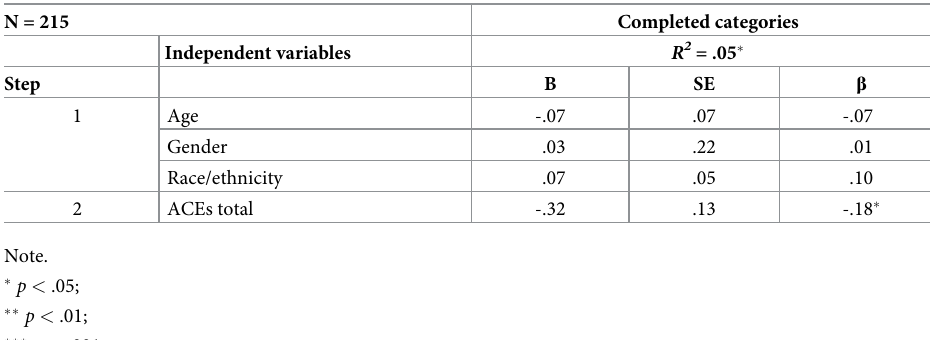
Table 3. Hierarchical multiple regression predicting completed categories on WCST in Study 1.